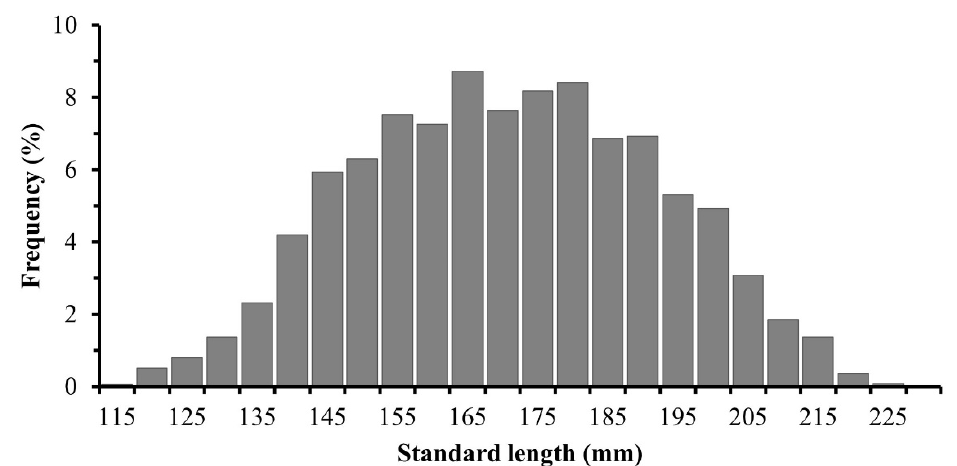
Figure 2. Standard length frequency distribution of the temperate Sardinops sagax stock in the southern California Current System (CCS) during the study period (2005–2014).